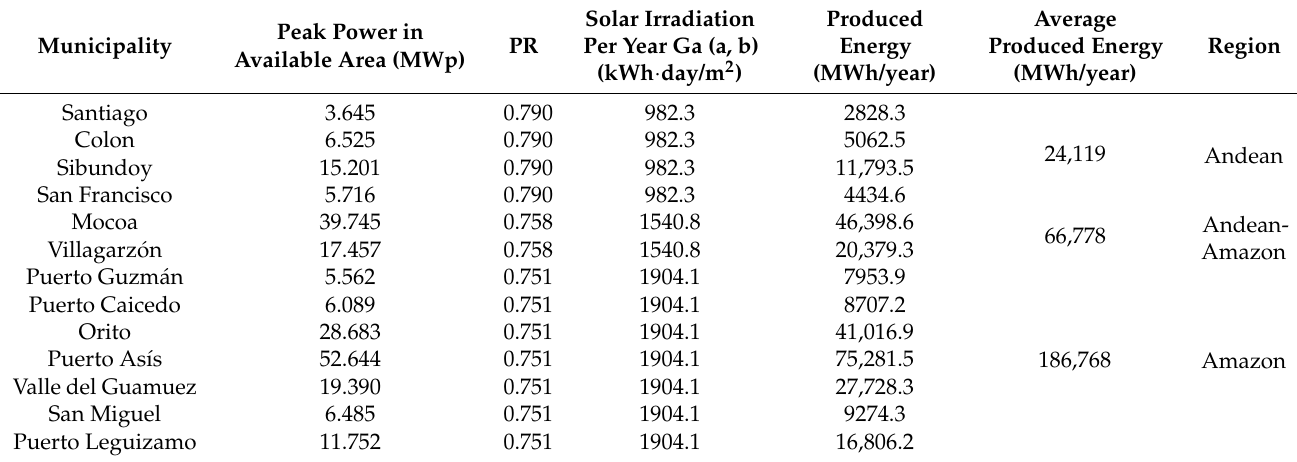
Table 8. Peak power and energy generated in the municipalities and regions of the department of Putumayo.